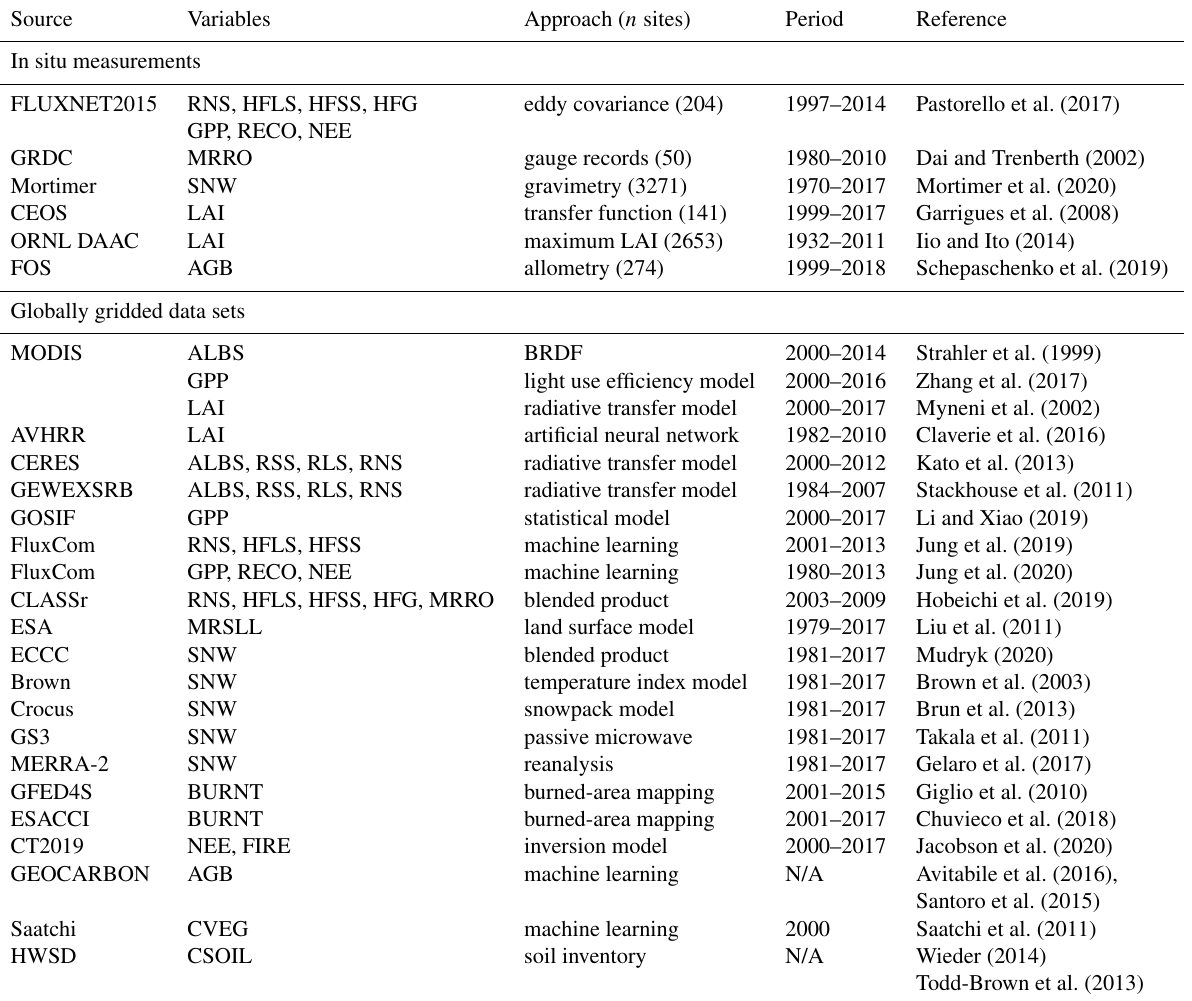
Table 1. Observation-based reference data used for model evaluation. Meanings of acronyms are provided in Sect. 2. N/A: not